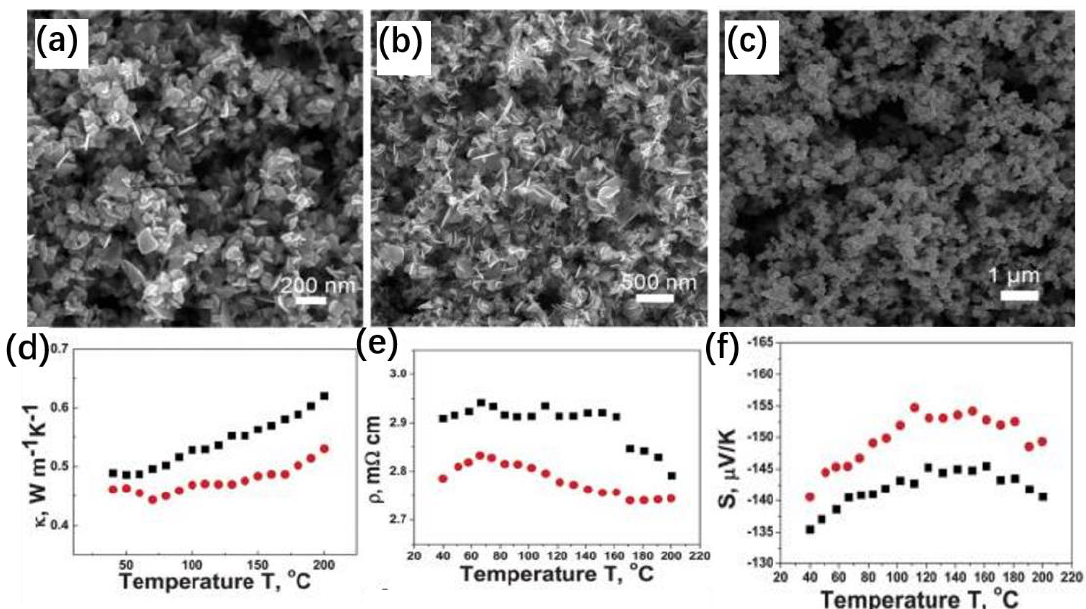
Figure 14. FESEM images of the Bi 2 Te 3 products obtained by adding different amounts of ethylenediaminetetraacetic acid (EDTA): ( a ) 0.01 g, ( b ) 0.03 g, and ( c ) 0.07 g. ( d ) Thermal conductivity, ( e ) electric resistivity, and ( f ) thermopower of plate Bi 2 Te 3 pellet (squares) and flower Bi 2 Te 3 pellet (circles). Copyright © The Royal Society of Chemistry 2012.